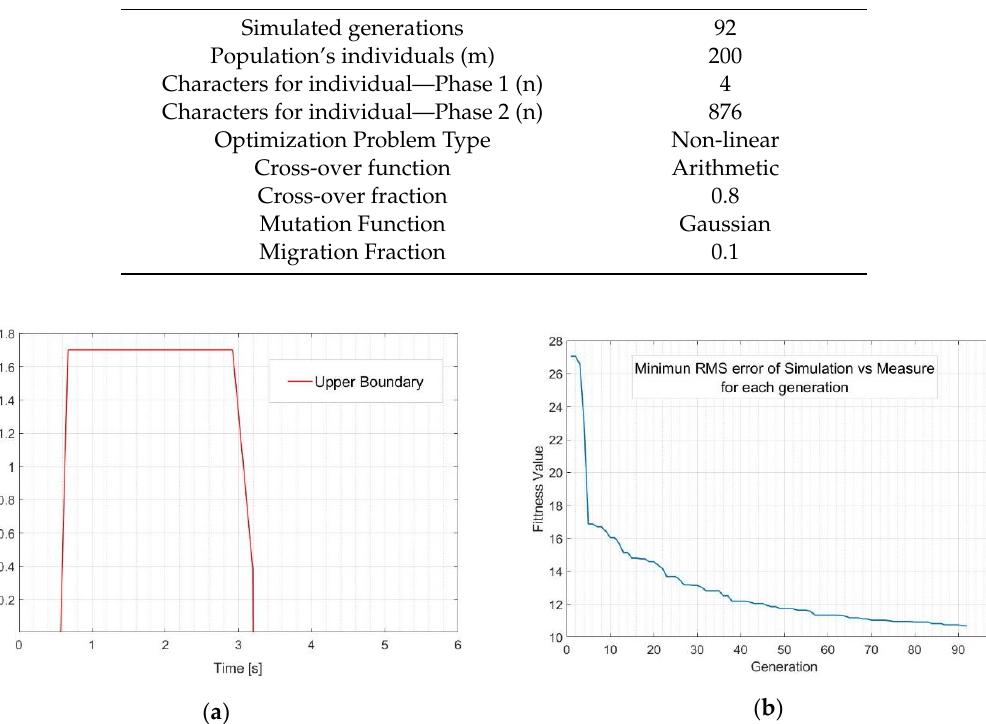
Figure 11. ( a ) Upper boundary limitation of the a-dimensional coefficient for the flux; ( b ) Trend of the objective function value for the best individual of the population in subsequent generations.